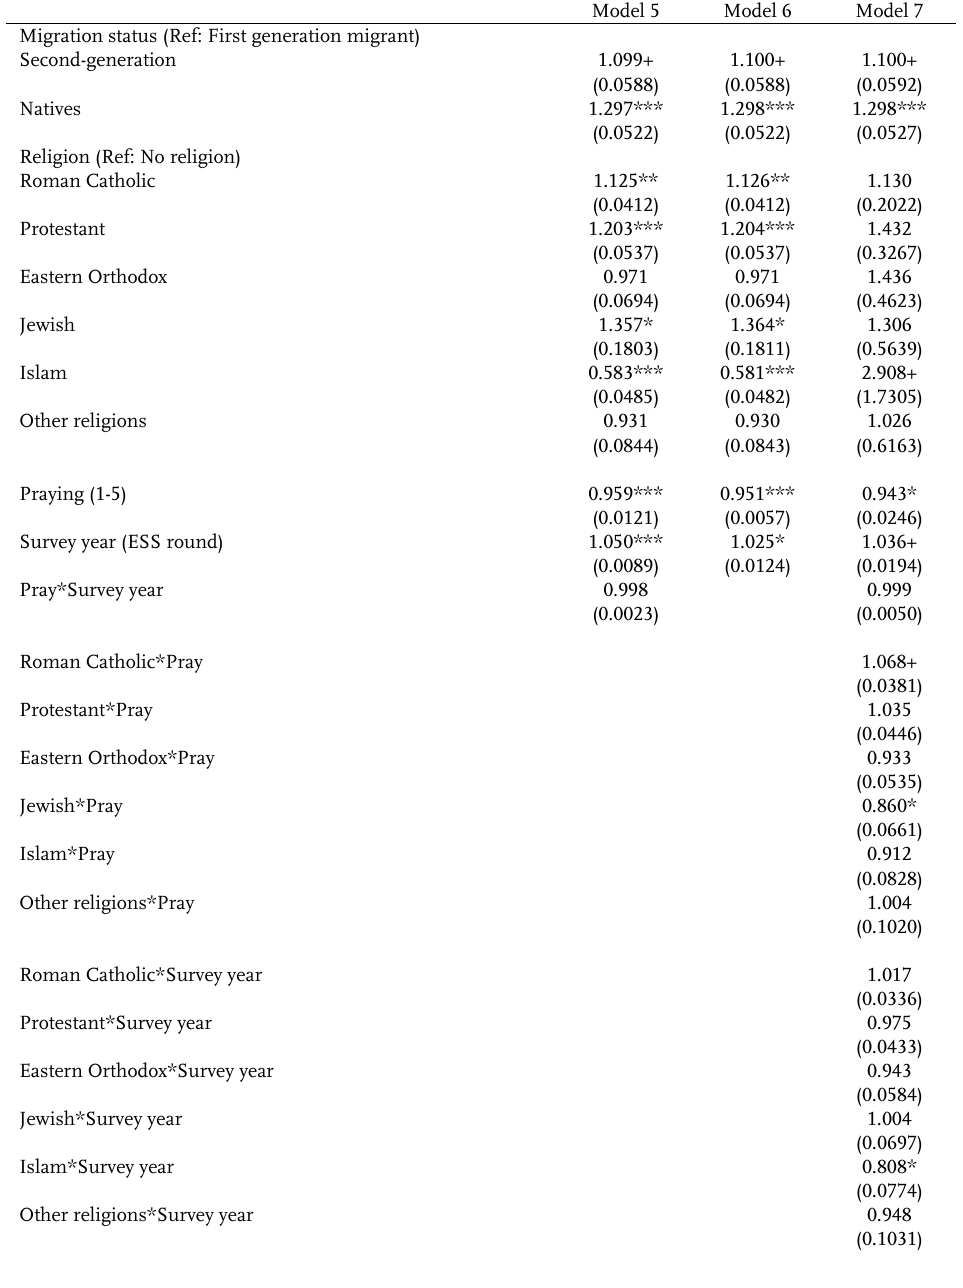
Table A.2 : Odd ratios role of religiosity and gender role attitudes on employment likelihood of women in different religion over time (Model 1, 2, 3 and 4 are in Table 4) (continued) Model 5 Model 6 Model